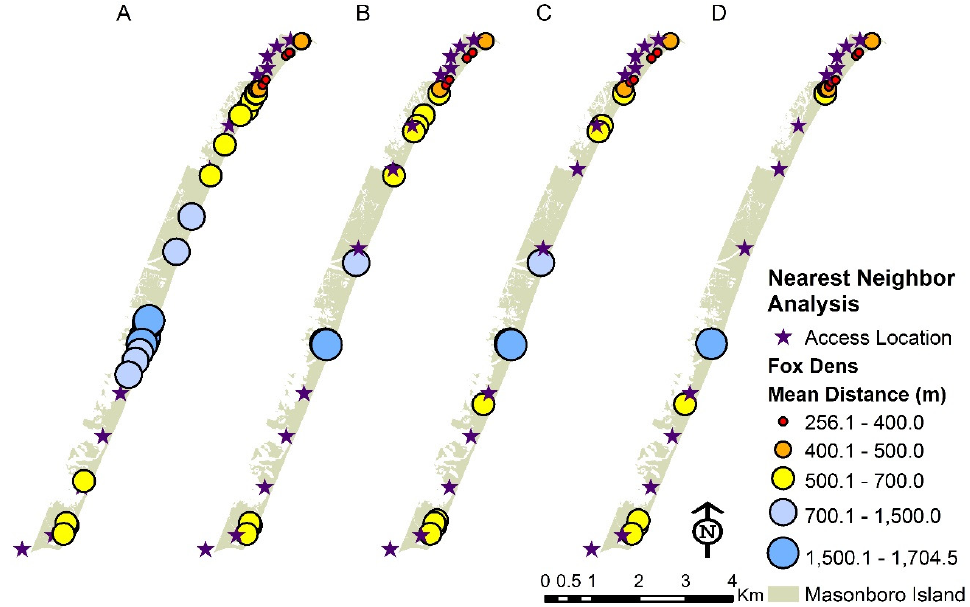
Figure 6. Mean distance (m) to the nearest two boat access sites: ( A ) 2009, ( B ) 2010, ( C ) 2011, and ( D ) 2012.